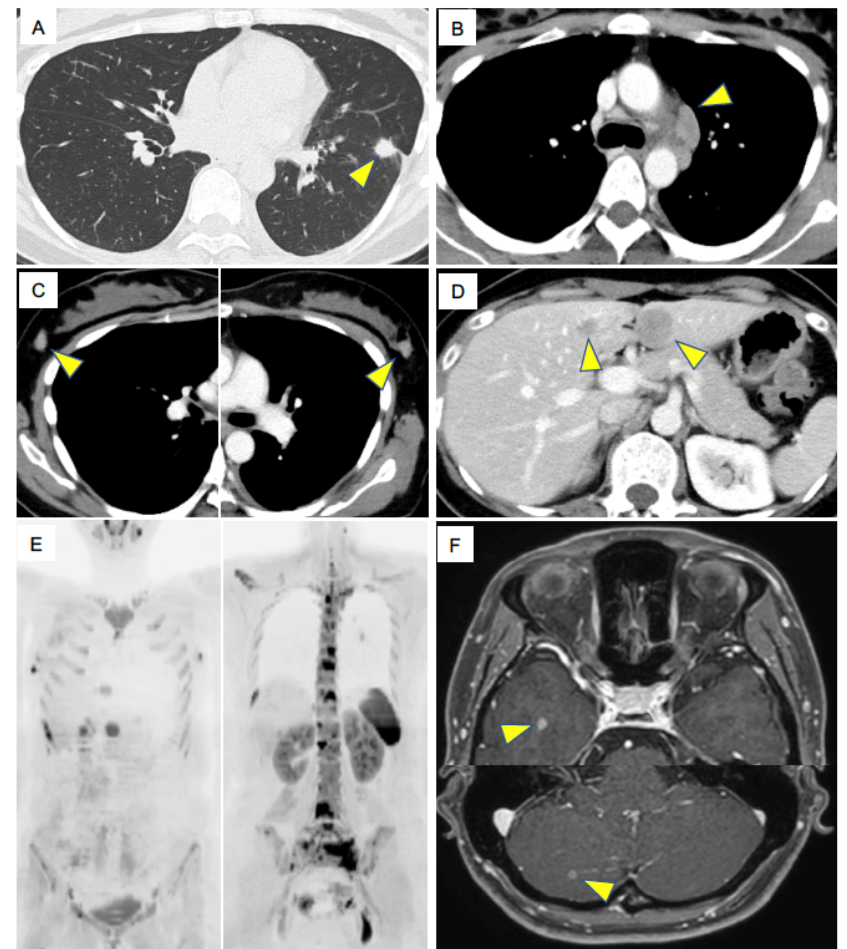
Figure 1. Key imaging results at diagnosis. ( A ). Chest computed tomography (CT) shows a primary lung tumor in the left lower lung. ( B ). Contrast-enhanced CT shows enlarged mediastinal lymph nodes (LNs). ( C ). Contrast-enhanced CT shows enlarged bilateral breast tumors. ( D ). Contrast-enhanced CT shows metastatic liver tumors. ( E ). Diffusion-weighted imaging of whole-body magnetic resonance imaging at the diagnosis shows multiple abnormal signals in the rib, pelvis and vertebral bodies, indicating multiple bone metastasis. Left panel also shows abnormal signals in bilateral breast tumors. ( F ). Contrast-enhanced brain MRI shows metastatic brain tumors. Arrowheads indicate metastatic tumors.